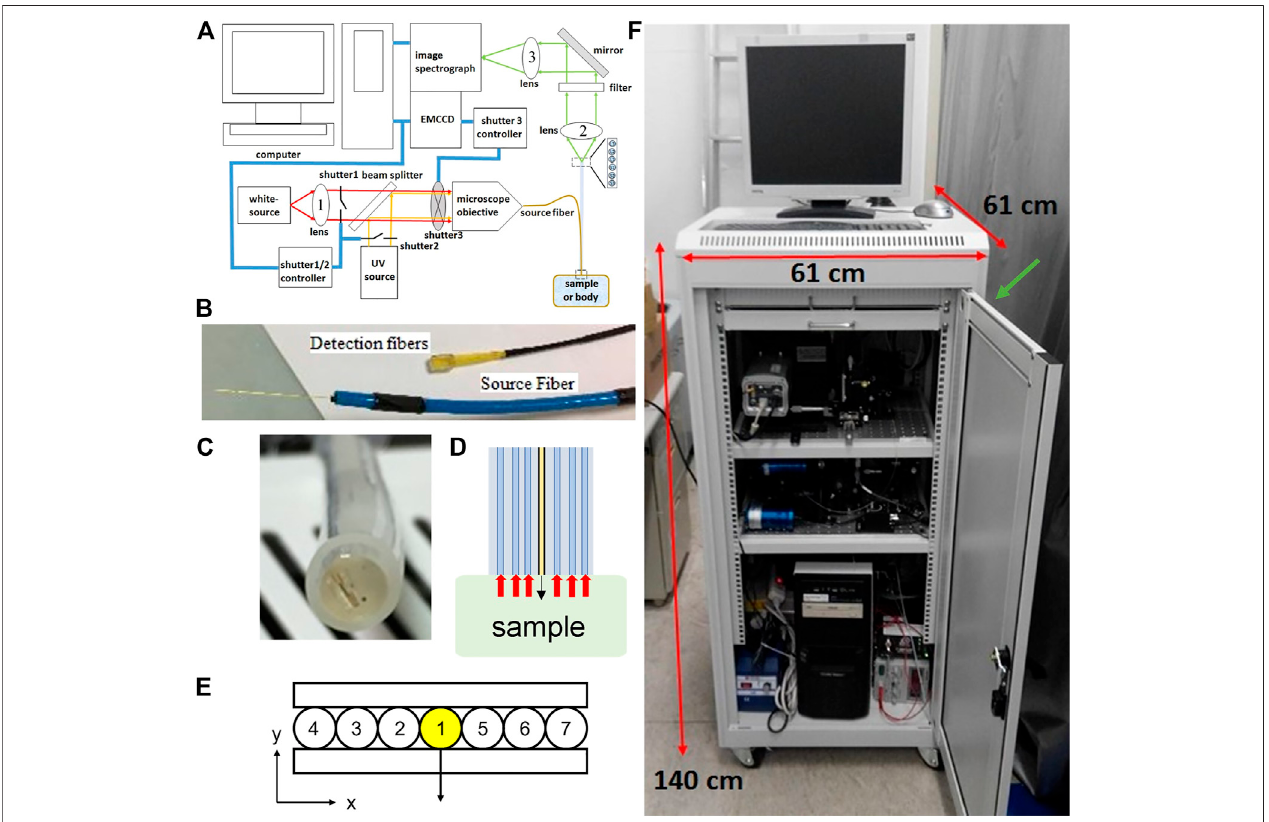
FIGURE 2 | (A) A schematic diagram of the spectroscopy system used (B) A photograph of the source fi ber and detection fi bers at the system end (C) A photograph of the end surface of the probe at the tissue/sample end (D) The probe side view interacts with the sample (E) A schematic diagram showing the arrangement of a source fi ber (#1), three detection fi bers (#2-#4) with SDS of 0.22, 0.41, and 0.61 mm respectively to the left of the source fi ber, and another three detection fi bers (#5-#7) with SDS of 0.215, 0.45, 0.73 mm respectively to the right of the source fi ber (F) A photograph of the custom-built movable spectroscopy system. A green arrow indicates the location where the probes come out of the